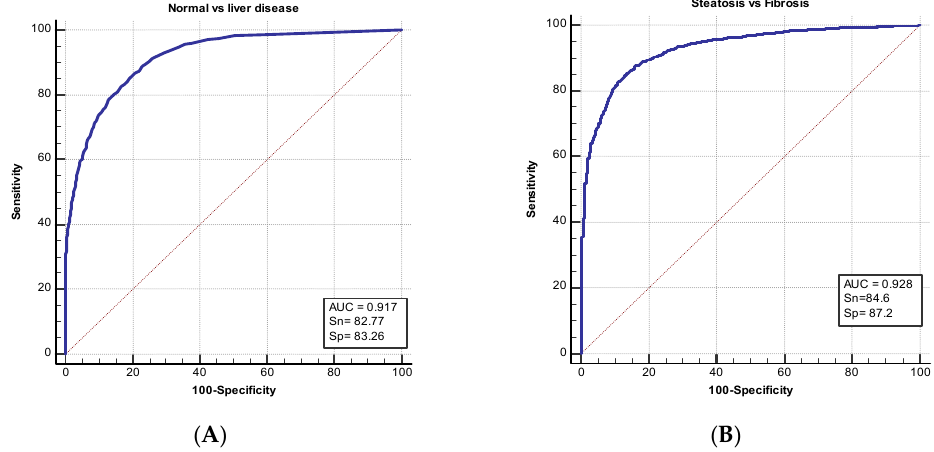
Figure 1. The diagnostic performance of quantitative liver texture ultrasound features using logistic regression (LR) machine learning for two-step pathology differentiation. ( A ) shows the diagnostic performance of ultrasound texture features in differentiating normal from liver disease including both fibrosis and steatosis cases, while ( B ) demonstrates the diagnostic performance of ultrasound features in differentiating steatosis from fibrosis cases. AUC refers to area under the curve, Sn: sensitivity, and Sp: